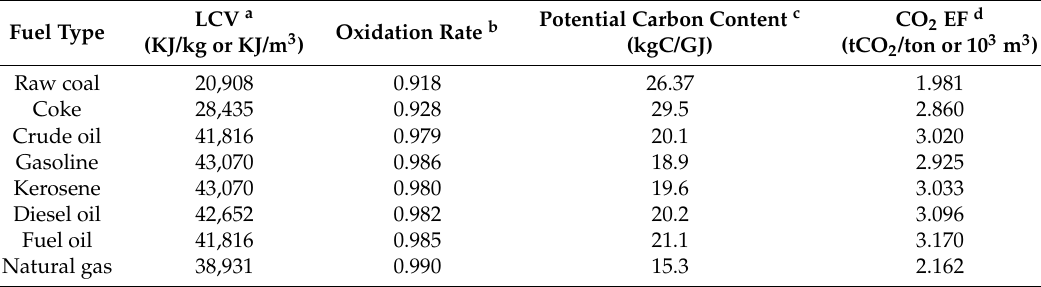
Table 1. CO 2 emission factors of various energy